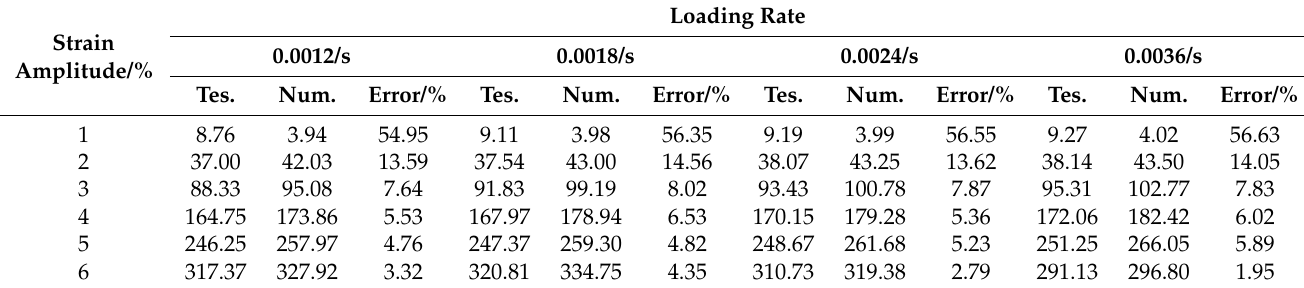
Table 8. Comparison of energy dissipation coefficient under different loading